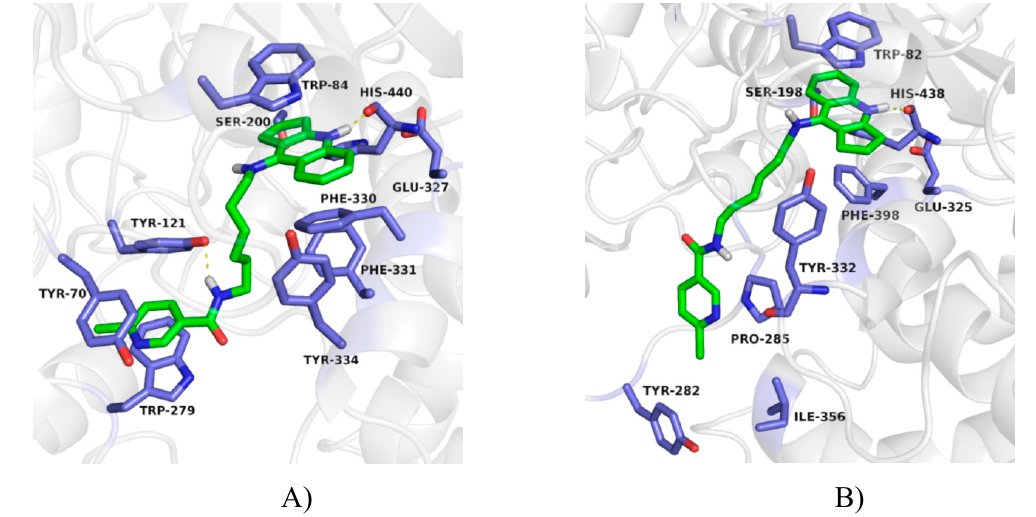
Figure 4. Binding mode of compound 3e with acetylcholinesterase ( A ) and butyrylcholinesterase ( B ).